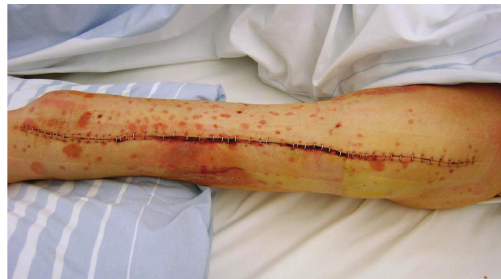
Figure 3: Left thigh 1 week postoperatively with a slight necrosis of the skin in central areas of the wound.